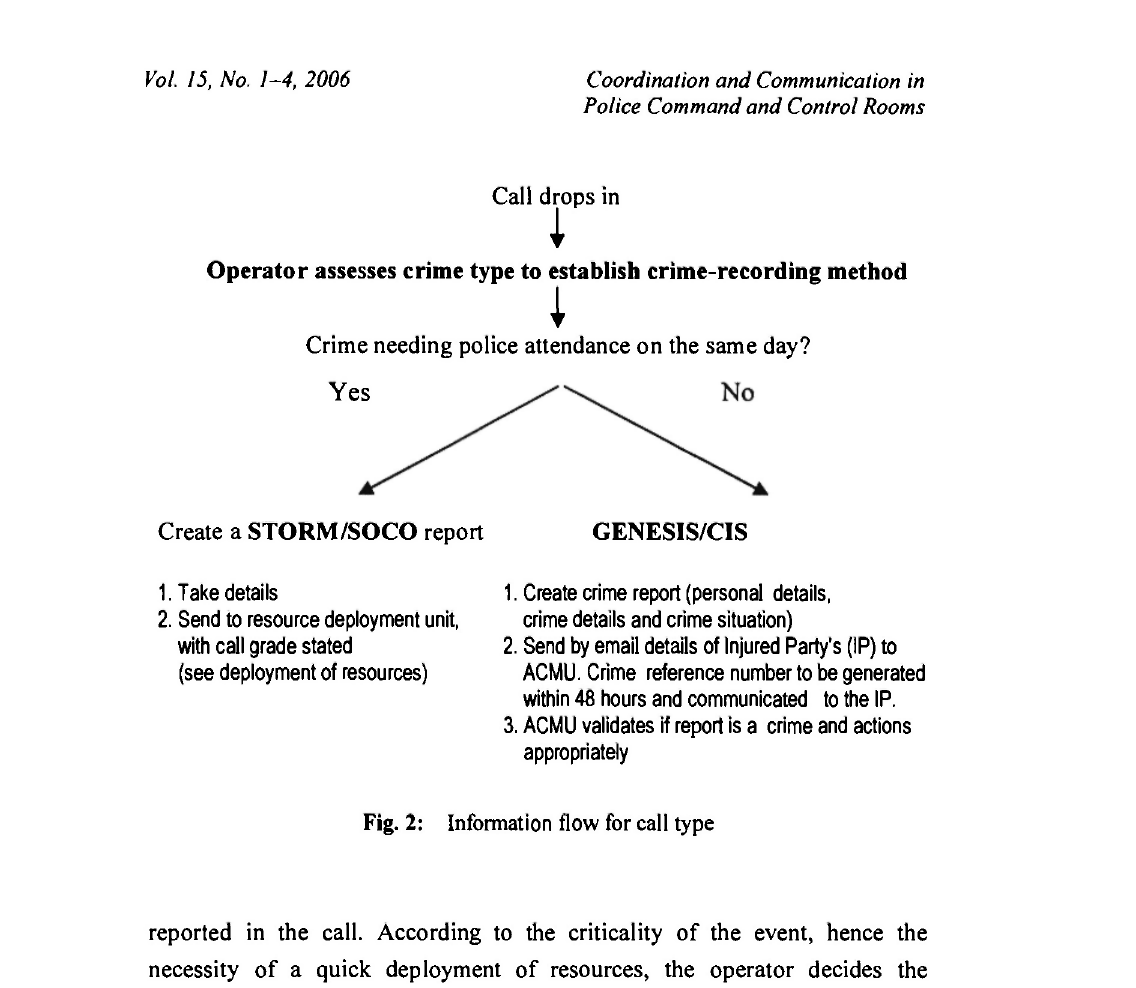
Fig. 2: Information flow for call